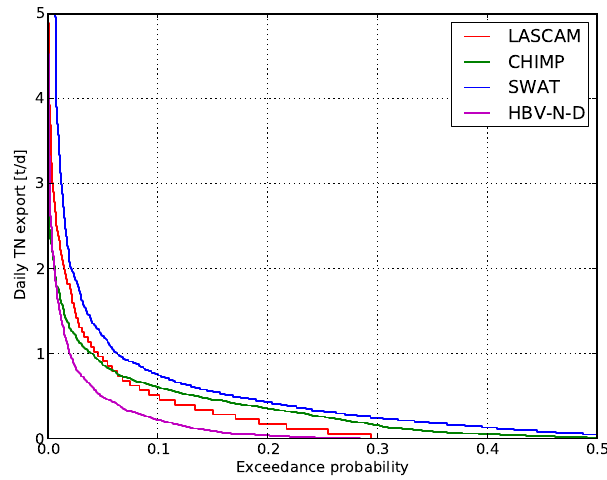
Fig. 3. Exceedance probability of daily TN exports as predicted by the models during the validation period (1998–2006).